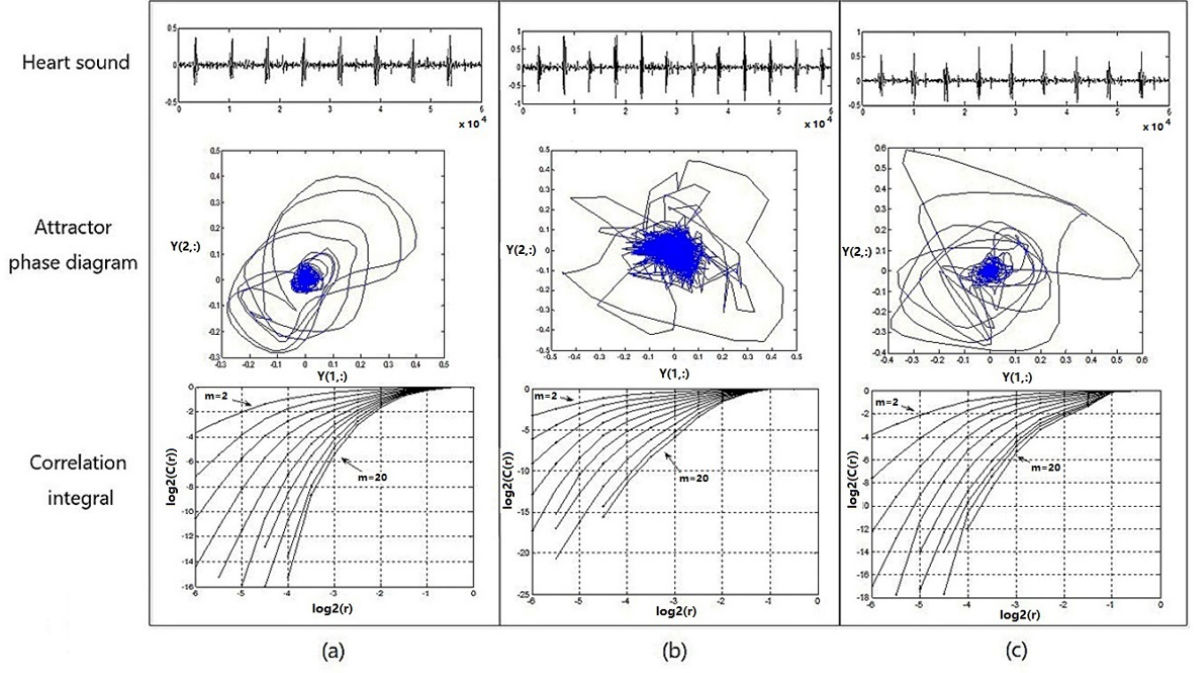
Figure 9. Heart sound waveform, attractor phase diagram, and associated integral distribution diagram for No. 1 test subjects under 3 states: ( a ) resting state—Step 1:A; ( b ) state of motion—Step 2:A; ( c ) recovery state after exercise—Step 3:A.